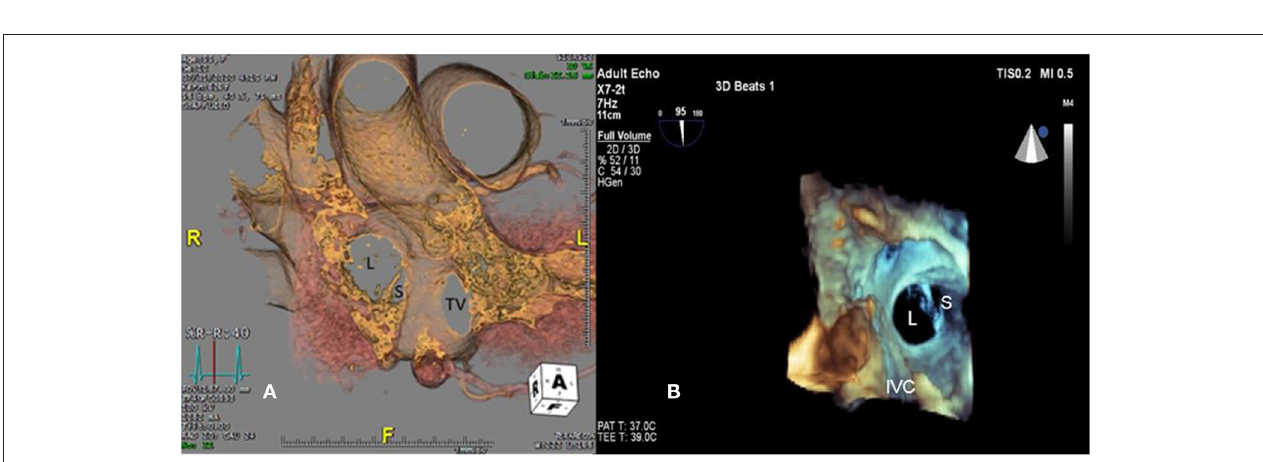
FIGURE 1 | iCTD (arrow) at the connection of the right atrium and inferior vena cava is shown in (A) transthoracic echocardiogram (TTE) and (B) three-dimensional TEE. LA, left atrium; RA, right atrium; CS, coronary sinus; IVC, inferior vena cava.